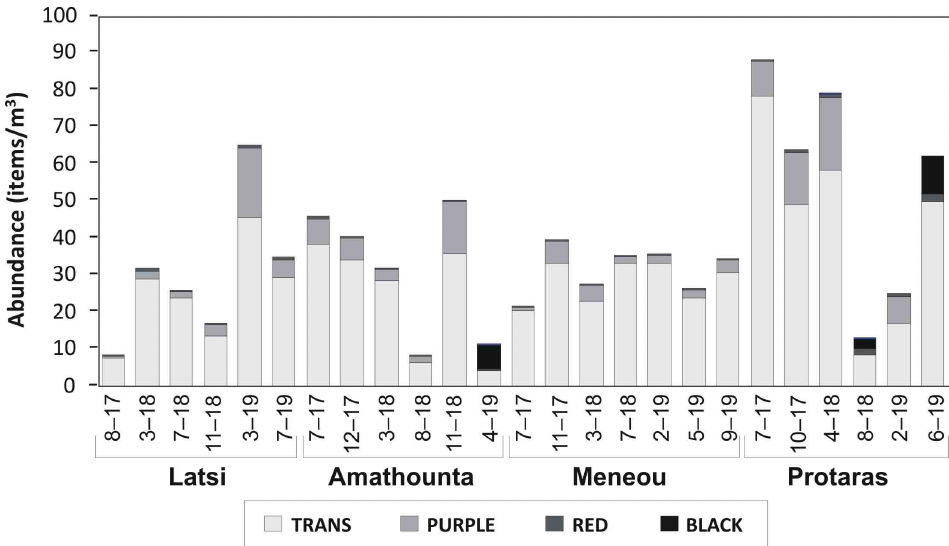
Figure 4. The cumulative abundance (items/m 3 ) of the different colors of the microplastic fibers recovered from each of the 25 samples in the four sampling areas (Latsi, Amathounta, Meneou and Protaras) during 2017–2019. (In each sample, the first number refers to the sampling month and the last two numbers to the sampling year.)